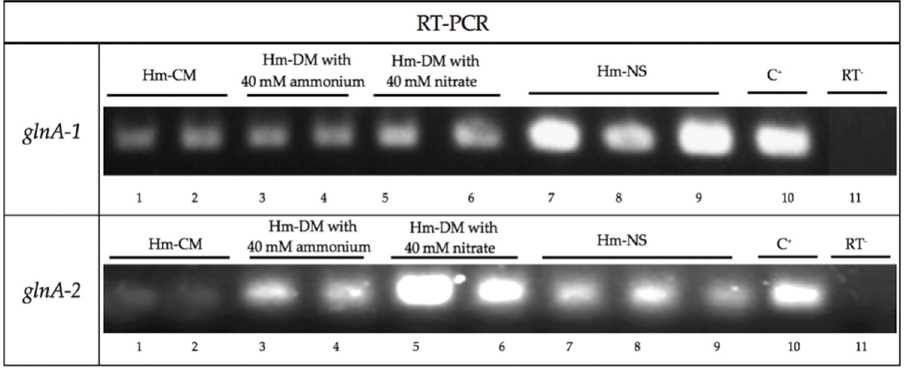
Figure 3. Analysis of the Hfx. mediterranei glnA genes expression by RT-PCR depending on nitrogen source. Lines 1-3-5: mid-exponential phase. Lines 2-4-6: stationary phase. Line 7: 48 h nitrogen star- vation. Lines 8: 96 h nitrogen starvation. Line 9: 120 h nitrogen starvation. Line 10: Positive control, DNA from Hfx . mediterranei strain R4. Line 11: Negative control, without reverse transcriptase.